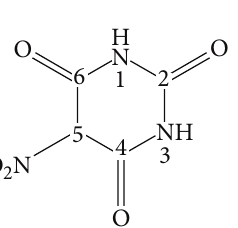
Figure 14: Raman spectra within the fingerprint region of 5-nitro- barbituric acid, quinidine, and the 1:1 nitrobarbituric-quinidine